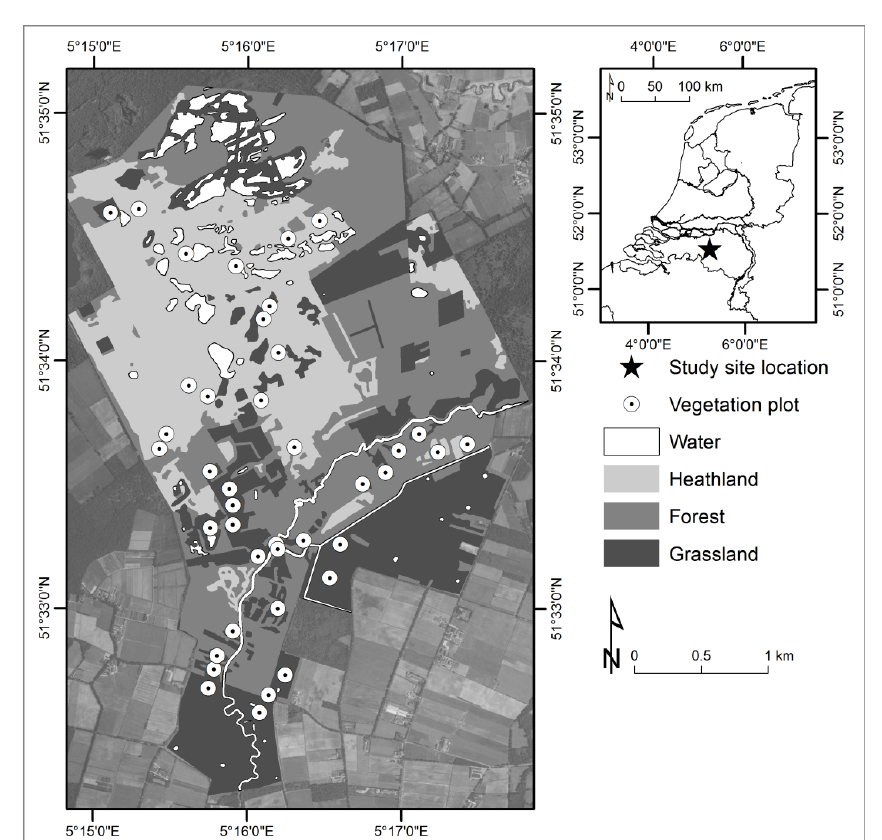
Figure 1. Overview of the study site, superimposed over an aerial photograph. Major vegetation types are indicated in grey shades. The 40 vegetation plots are only located in heathlands or